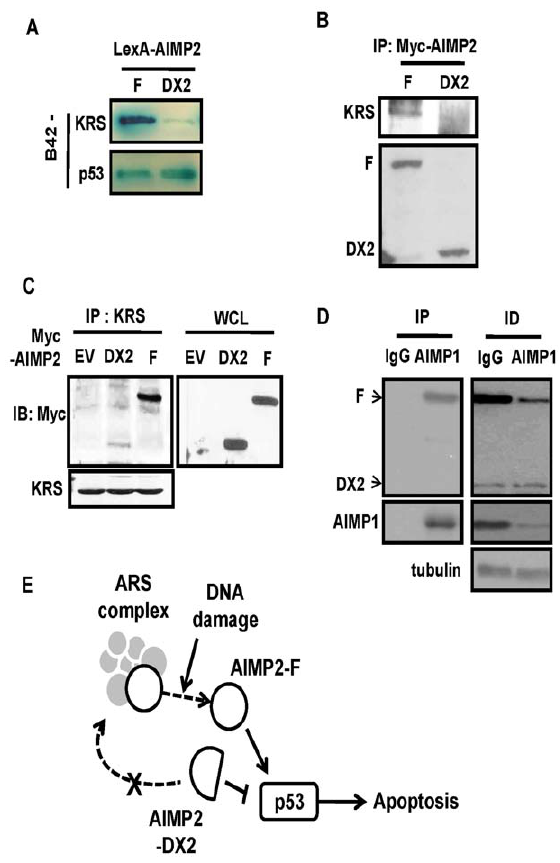
Figure 5. Differential interaction of AIMP2-F and –DX2 with the multisynthetase complex. (A) The interaction of AIMP2-F and –DX2 with the multi-synthetase complex was determined by yeast two hybrid assay using KRS as the target protein. p53 was used as a positive control and the positive interaction was indicated by the blue colony formation on X-gal-containing yeast medium. (B) The interaction of AIMP2-F and – DX2 with KRS was tested by co-immunoprecipitation assay. Myc-AIMP2- F or –DX2 was expressed in 293 cells and immunoprecipitated with